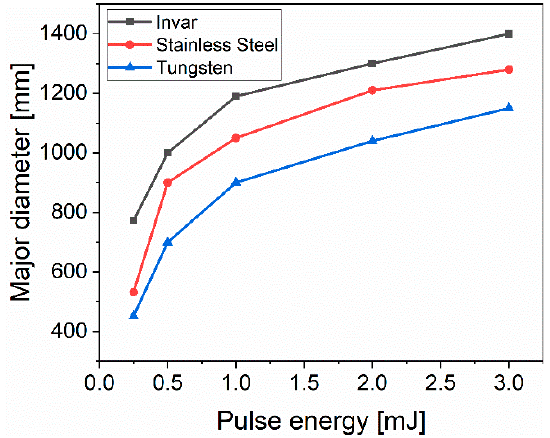
Figure 3. The major diameter of the elliptical interference area with a dependence on pulse energy.